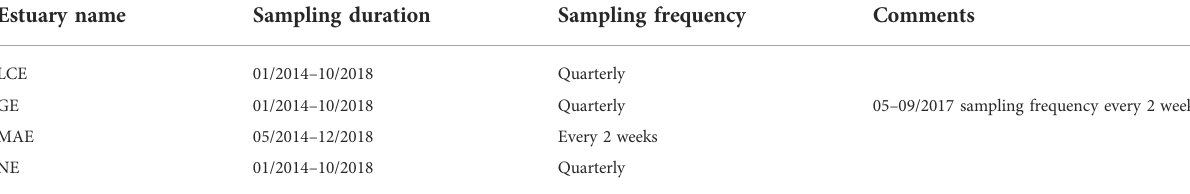
TABLE 1 Sampling times at the four studied nwGOM